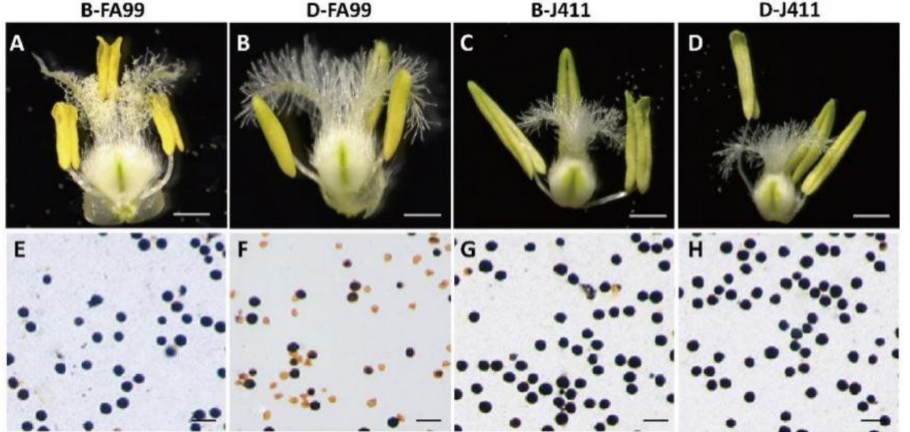
Figure 1. Phenotypic characteristics of FA99 and J411 in different fertility conditions. ( A , E ) B-FA99 (FA99 in the fertile condition); ( B , F ) D-FA99 (FA99 in the sterile condition); ( C , G ) B-J411 (J411 in the fertile condition); ( D , H ) D-J411 (J411 in the sterile condition); ( A – D ) Floret at the trinucleate stage; ( E – H ) I 2 -KI staining of pollen grains. Scale bars = 500 µ m ( A – D ); 100 µ m ( E – H